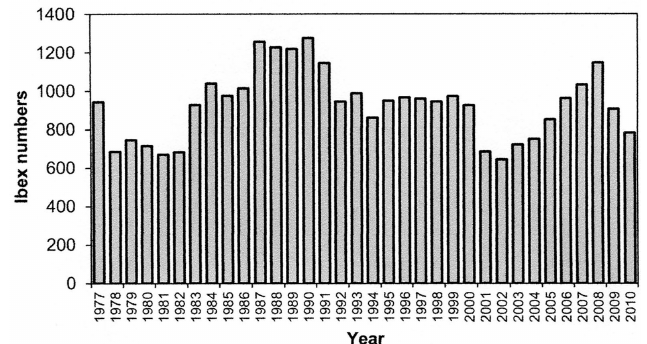
Figure 15: Fluctuations in numbers of the ibex population on Munt da la Bês-cha (including Val Chamuera). Data gratefully received from ‘Amt für Jagd- und Fischerei Graubünden‘, 2011.